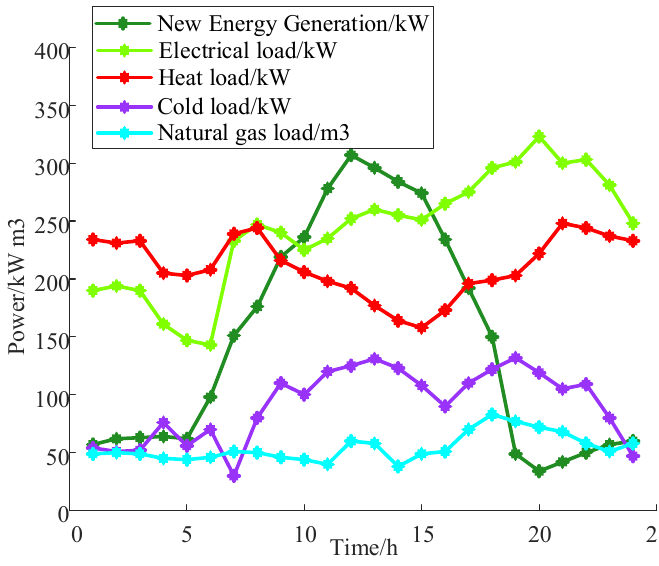
Figure 2. New energy power generation and load day prediction.